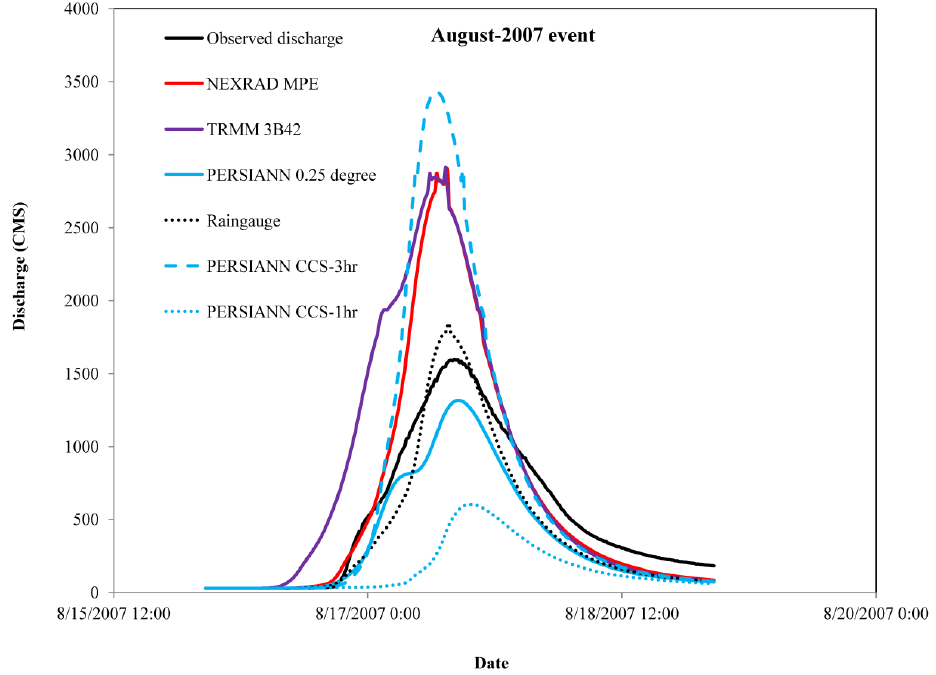
Figure 12. Comparison of observed and simulated streamflow for the August 2007 storm